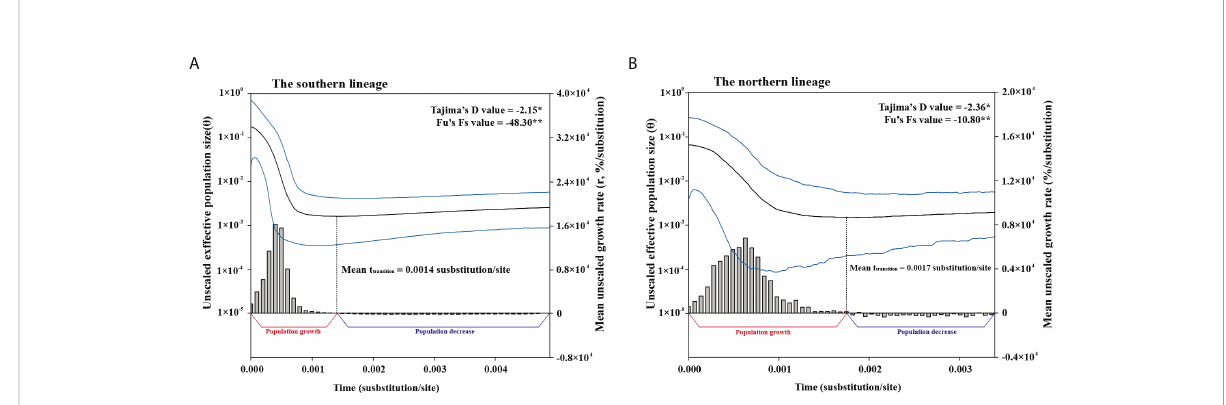
FIGURE 5 Bayesian skyline plots and inferred mean grow rate dynamics of the southern (A) and northern (B) lineages of T. barbatus . Mean (black), upper and lower limits of 95% HPD intervals (blue) of unscaled effective population size are presented in curves with logarithmic Y axis on the left, and the growth rate dynamic is presented in bar chart with Y axis on the right. Tajima ’ s D and Fu ’ s Fs values of each lineage are given at top-right corner. Mean uncalibrated transition time of each lineage is